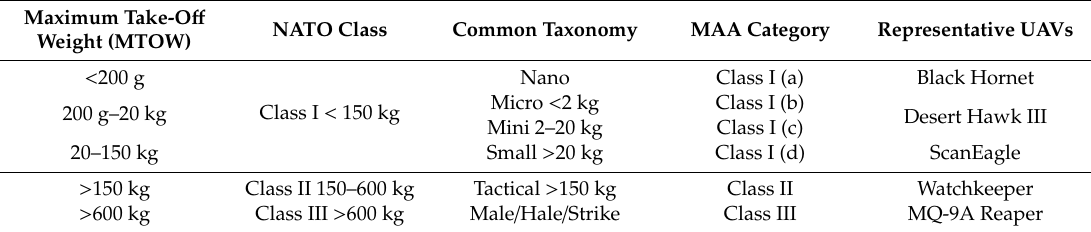
Table 1. NATO and UK unmanned aircraft